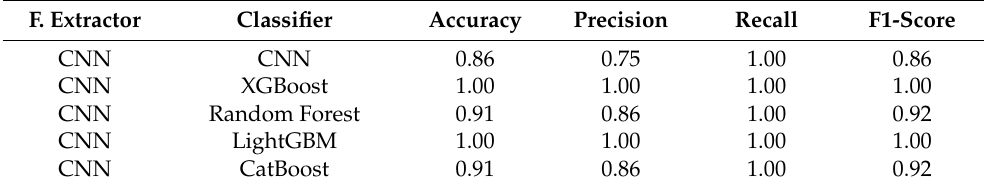
Table 1. Obtained results: accuracy, precision, recall and F1-score for all experiments. F.